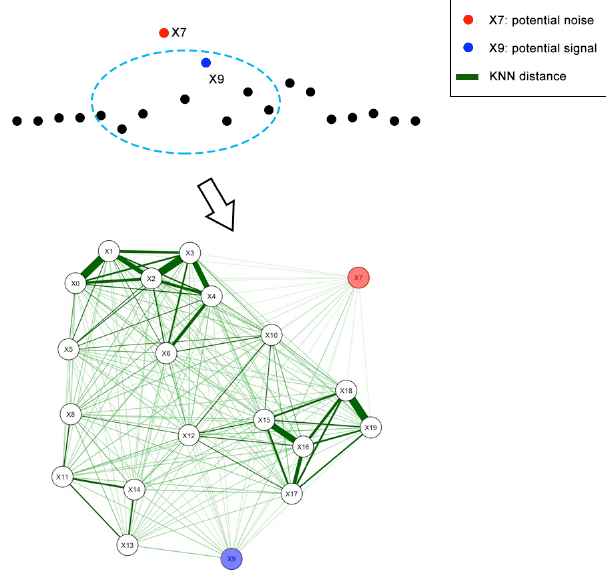
Figure 5. The distance matrix from the horizontal ellipse searching area, a darker and thicker line indicates closer reachability between these